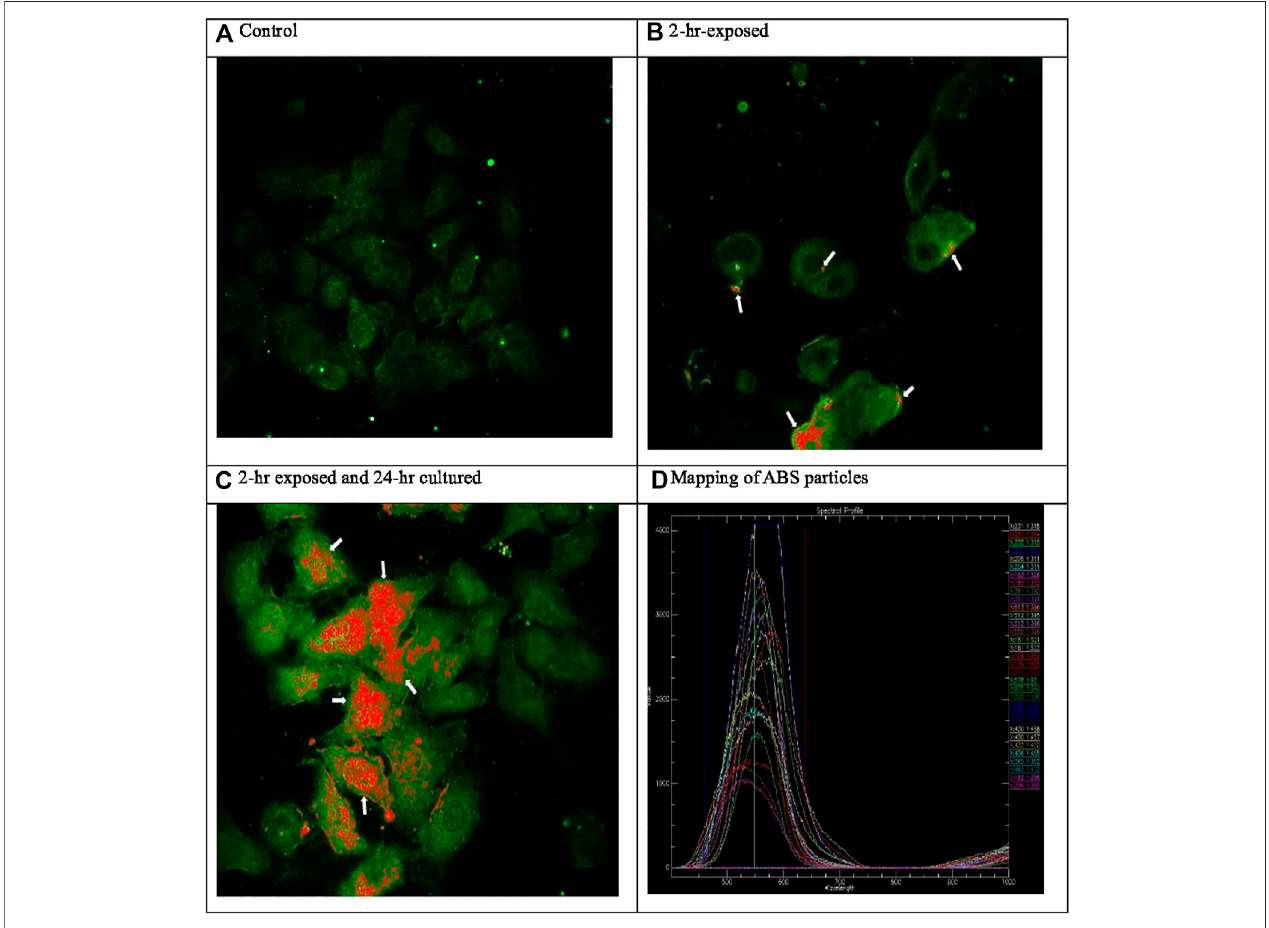
FIGURE 3 | Hyperspectral microscopic images of ABS particle exposed A549 cells (400x). ABS particles deposited to the glass coverslips were scanned and obtained hyperspectral pro fi les (D). (A) Control. (B) 2-h exposed. (C) 2-h exposed and 24-h cultured. (D) Mapping of ABS particles.